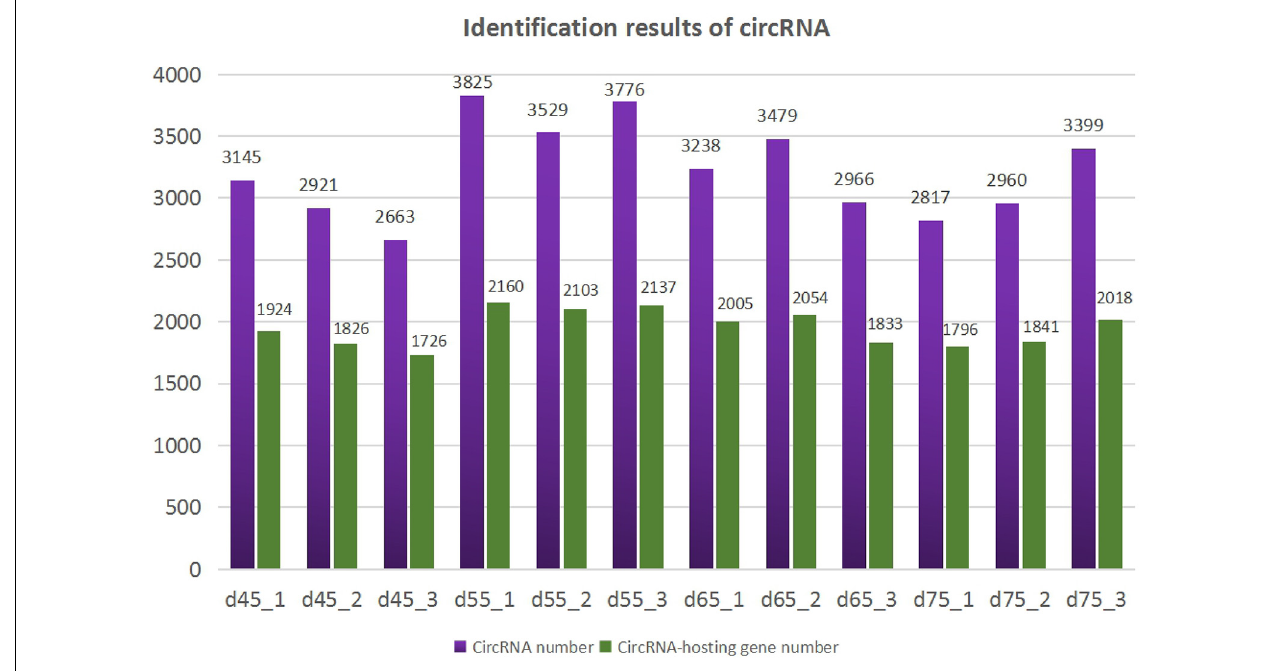
FIGURE 1 | Identification results of circRNAs. The purple columns represent the number of circRNAs, and the green columns represent the number of circRNA-hosting genes.